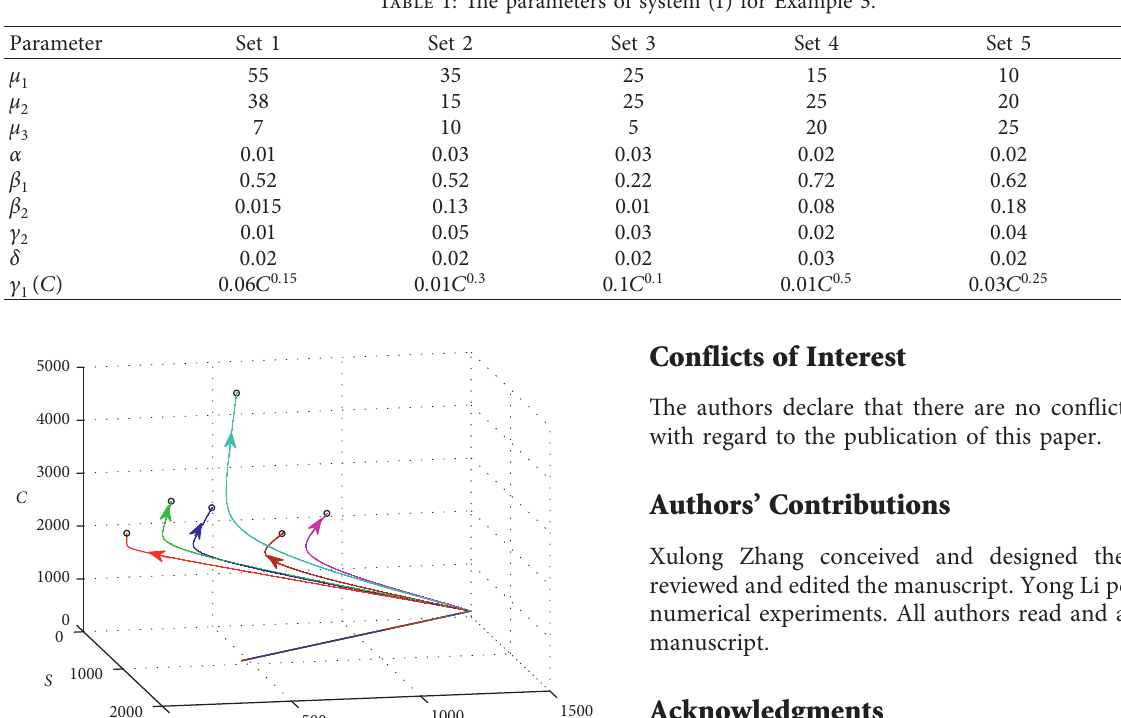
Table 1: The parameters of system (1) for Example 3.